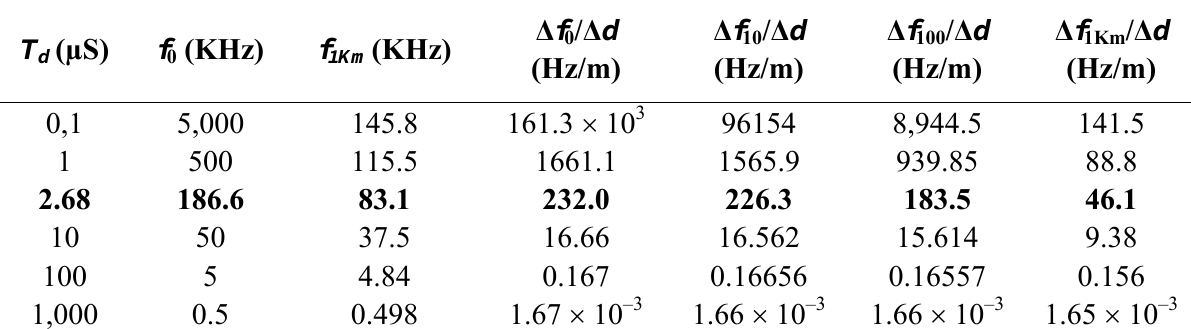
Table 2. Frequencies and sensitivity versus distances: T and f frequency detected for 0 or 1 Km distance, Δ f repetition, f 0 1Km sensitivity at 10 m and 1 Km respectively.